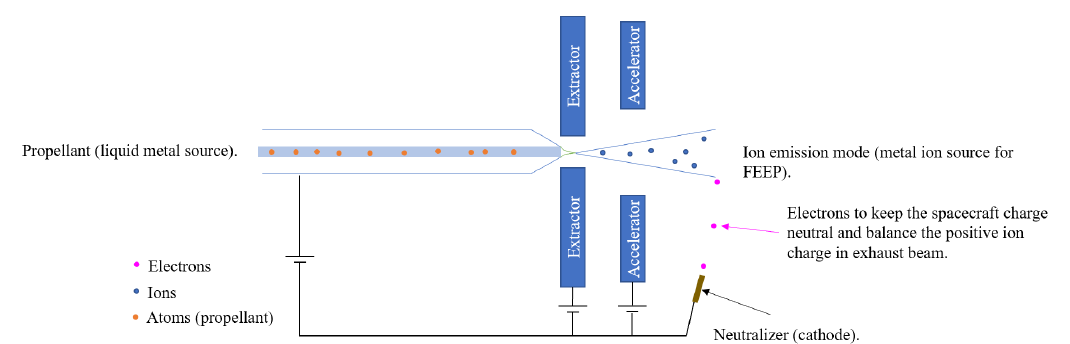
Figure 4. A FEEP thruster as a simplified schematic diagram. Addition of a neutralizer and metal ion source in comparison to Colloid electrospray